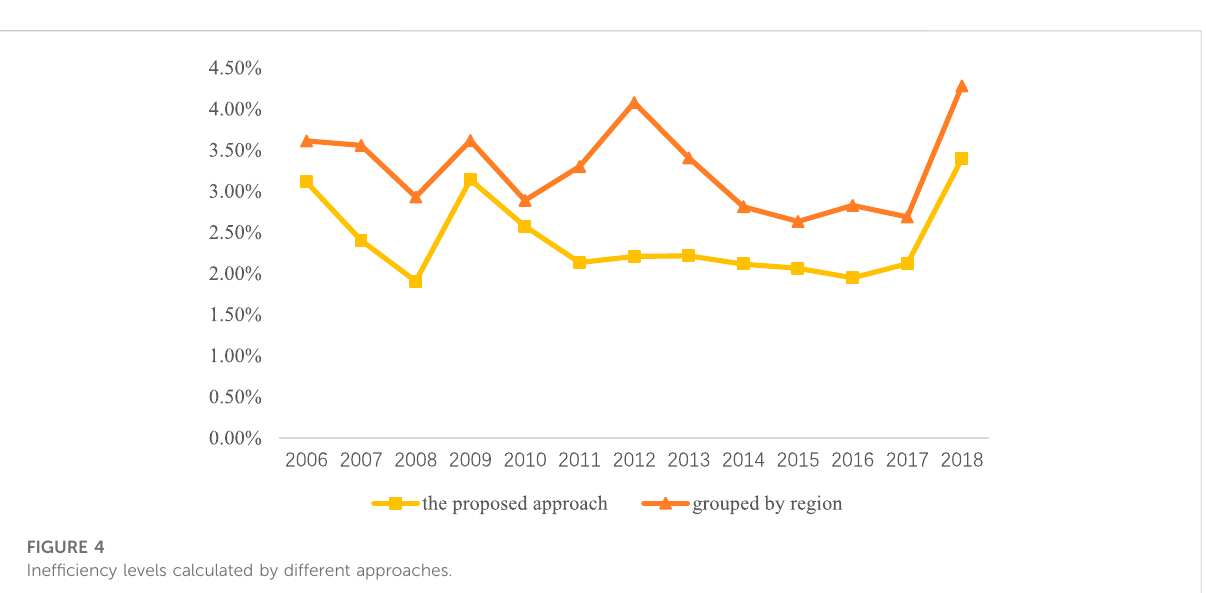
FIGURE 4 Inef fi ciency levels calculated by different